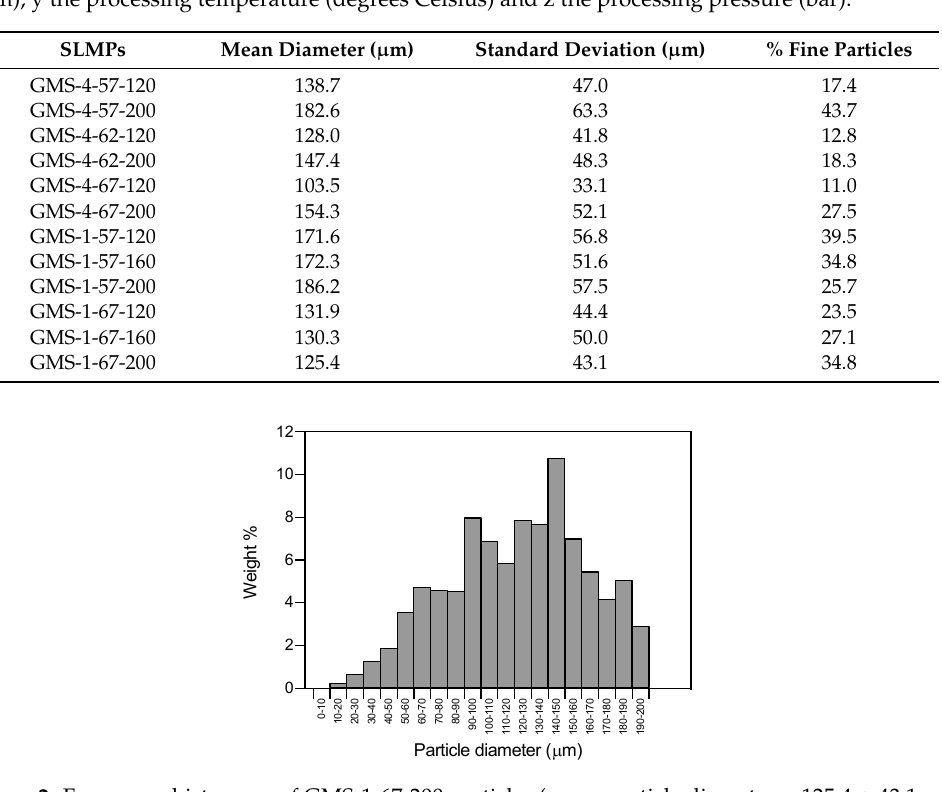
Figure 2. Frequency histogram of GMS-1-67-200 particles (mean particle diameter = 125.4 ± 43.1 μm). The normal distribution of this histogram is representative of all the GMS formulations tested.